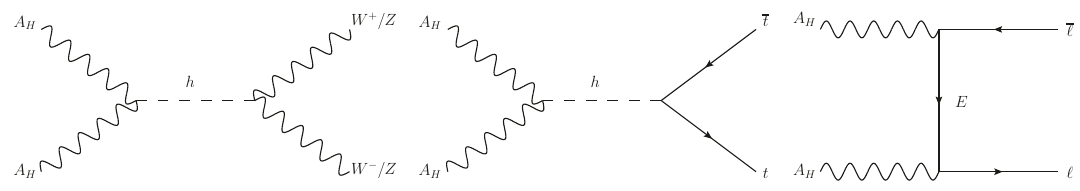
Figure 14 . Relevant annihilation processes for the dark photon in the standard freeze-out mecha-